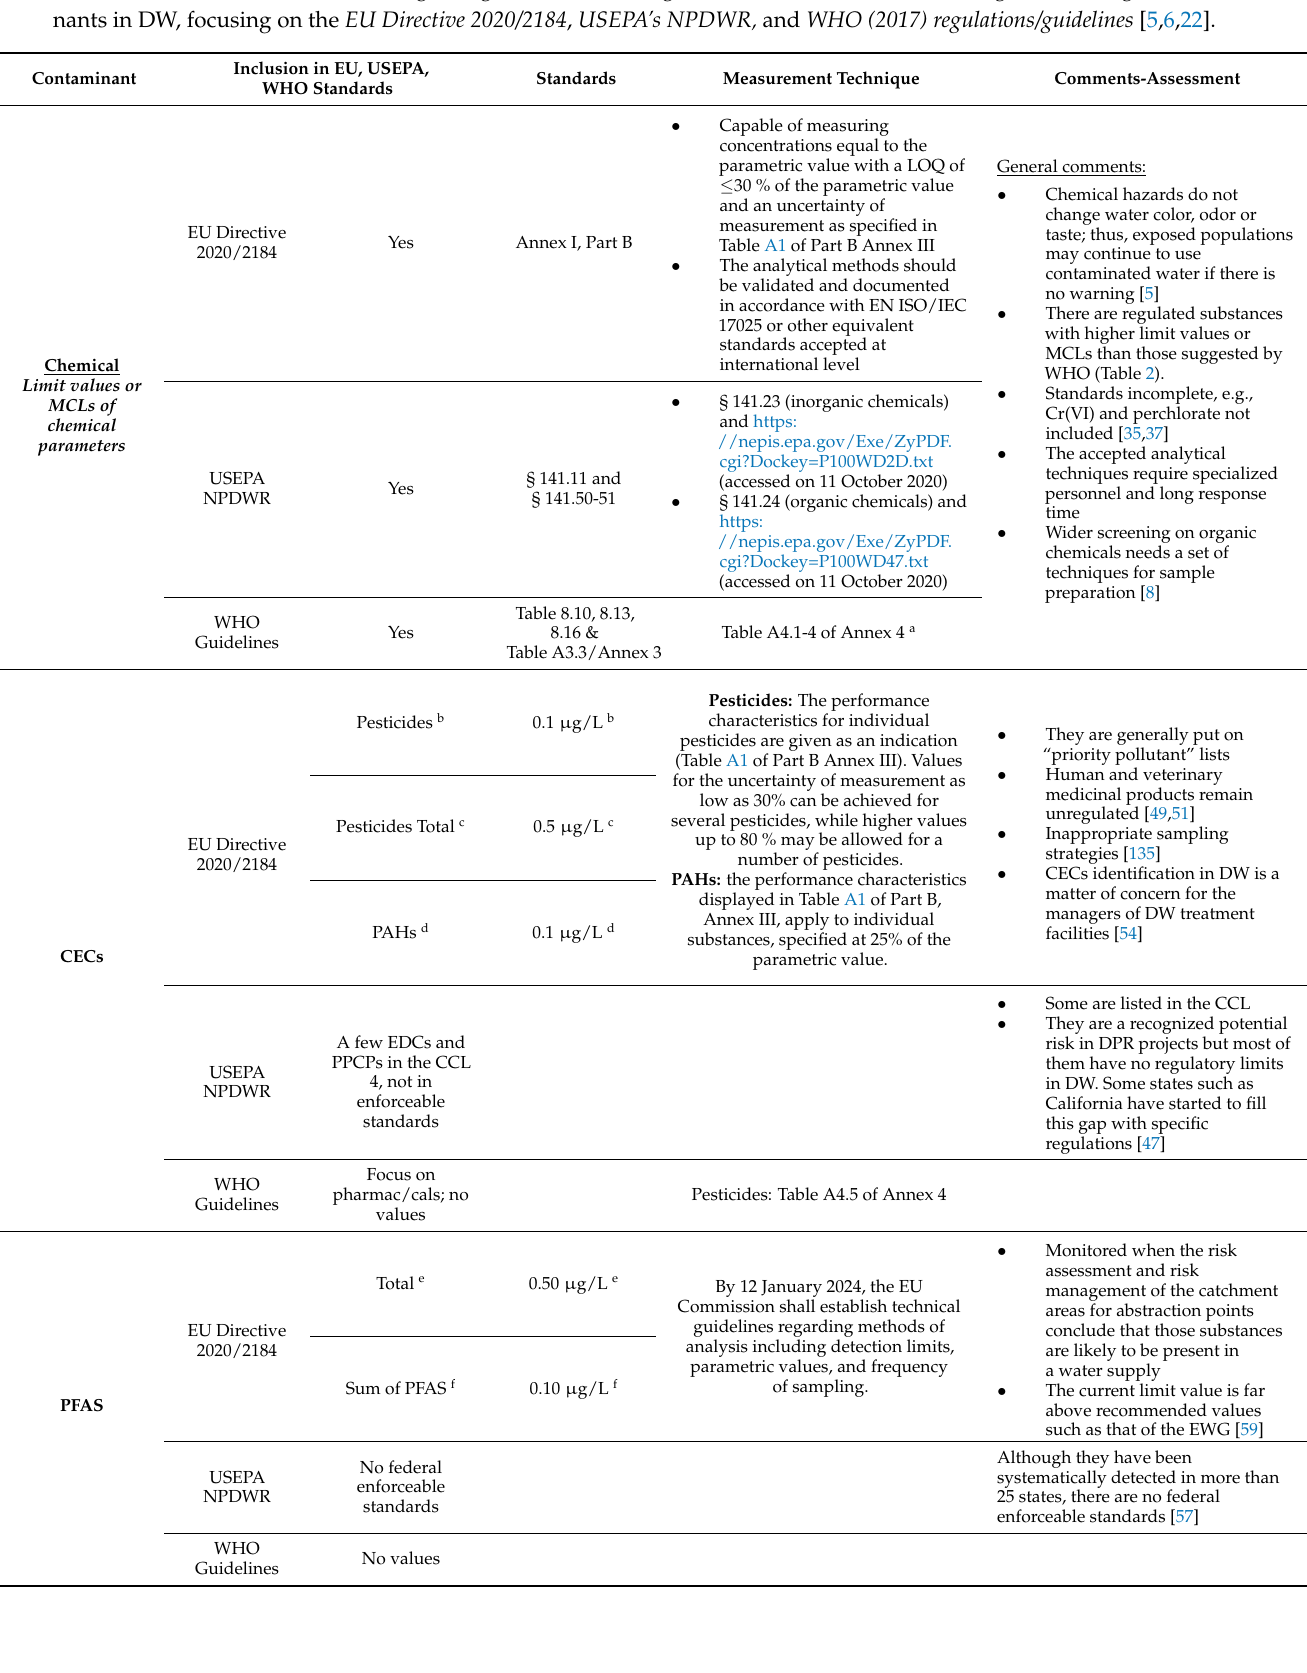
Table A1. Overview of assessment regarding the standards/regulations for chemical, microbiological, radiological contami- nants in DW, focusing on the EU Directive 2020/2184 , USEPA’s NPDWR, and WHO (2017) regulations/guidelines [5,6,22].